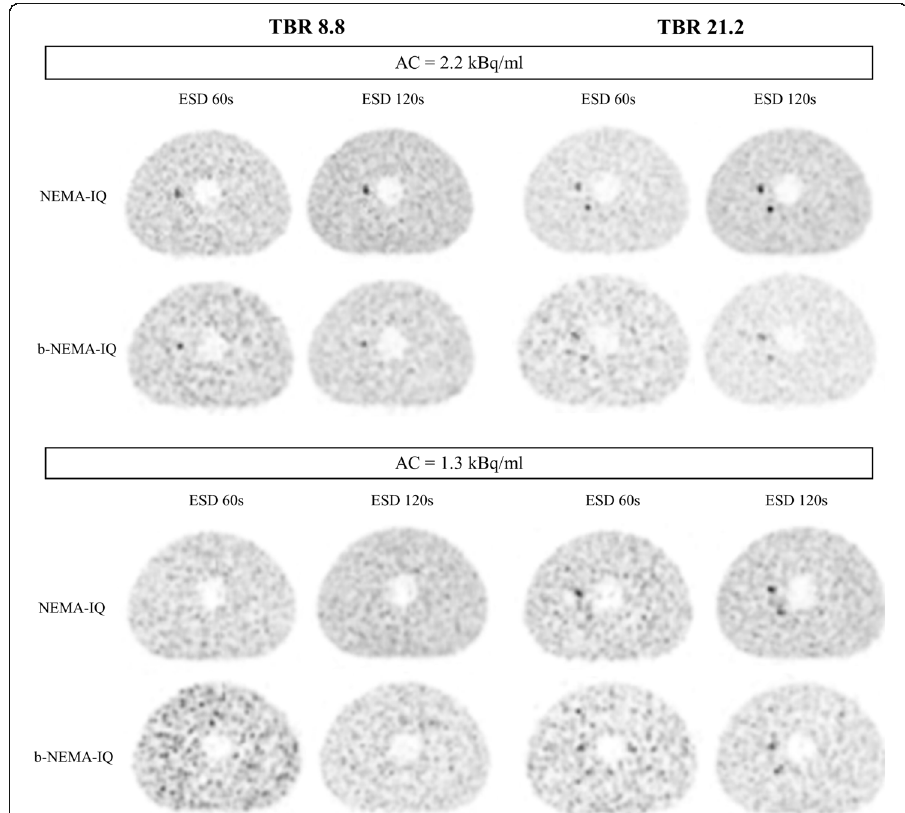
Fig. 7 Equatorial slices of microspheres for NEMA-IQ and b-NEMA-IQ phantoms for intermediate (8.8) and high (21.2) TBR, two values of AC (1.3 and 2.2 kBq/ml) and two values of ESD (60 and 120 s). The impact of increasing ESD or AC is evident in the greater visibility of the 8.1-mm microsphere. The increase of TBR allows visibility of the 6.5-mm microsphere. At intermediate TBR (8.8) and low AC (1.3 kBq/ml), no microsphere is